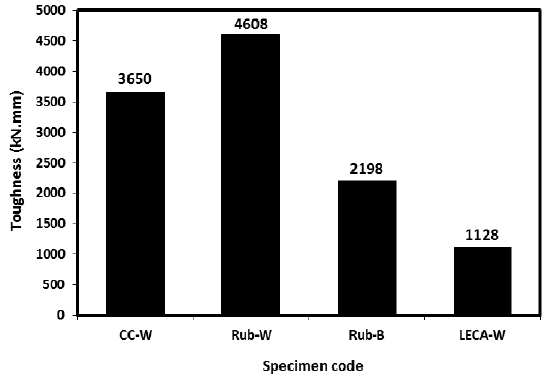
Figure 8. Flexural toughness for tested specimens.